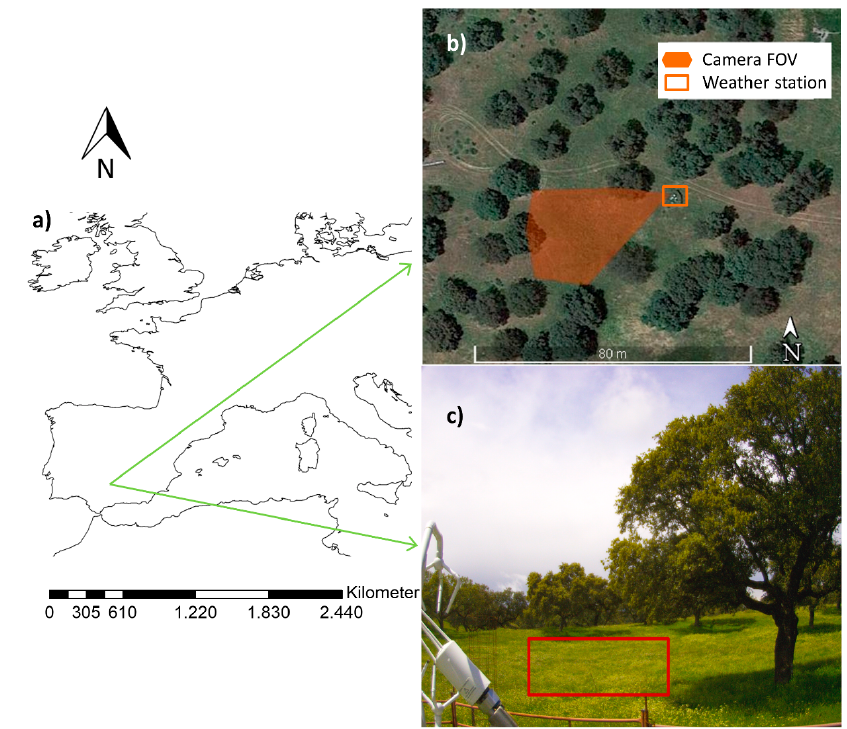
Figure 1. ( a ) Farm location. ( b ) Aerial photography of the experimental site, including the location of the weather station and the terrestrial digital camera and its field of view (FOV). ( c ) Image from the terrestrial digital camera and region of interest (ROI) for natural grass used in the analysis (red